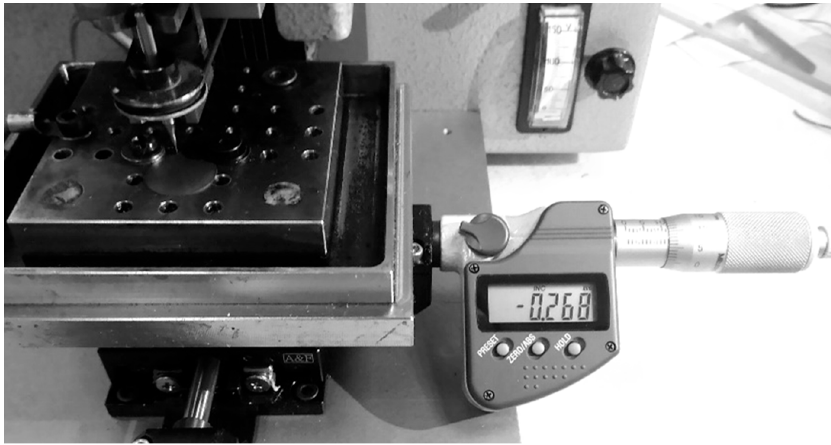
Figure 7. X direction manual control by digital micrometer head.